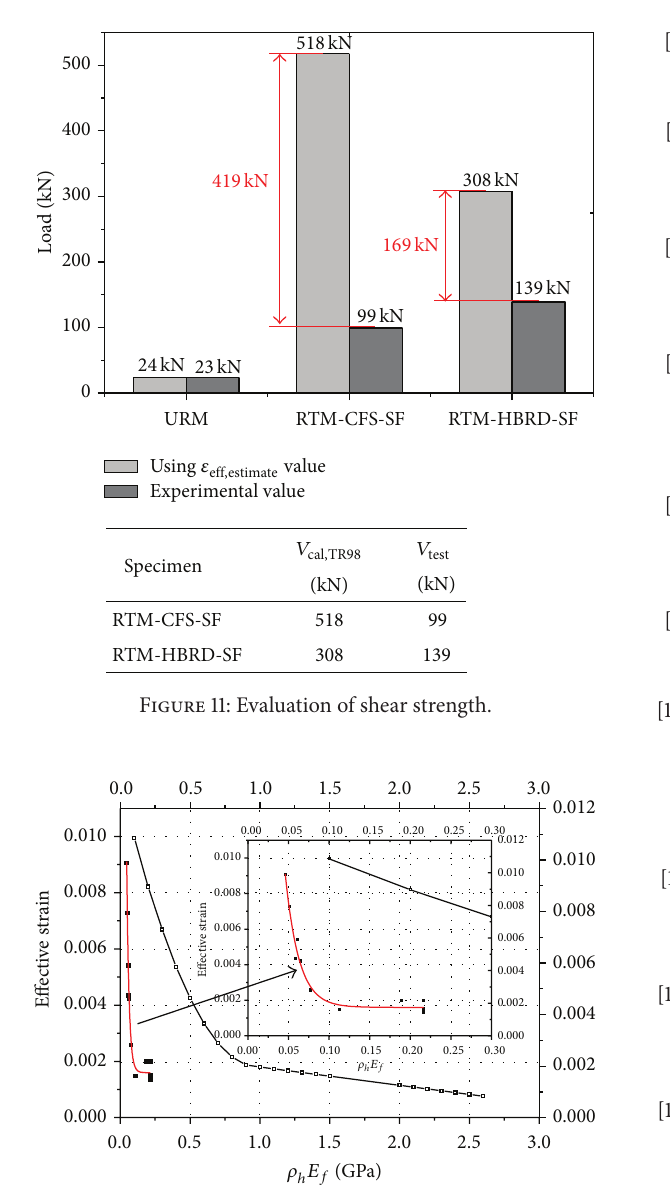
Figure 12: Effectiveness strain distribution according to retrofit